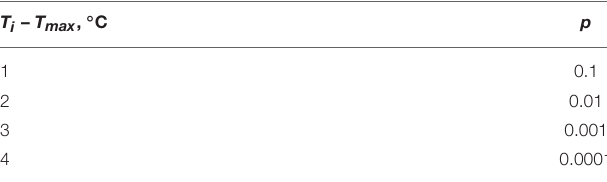
TABLE 6 | Tolerable risk